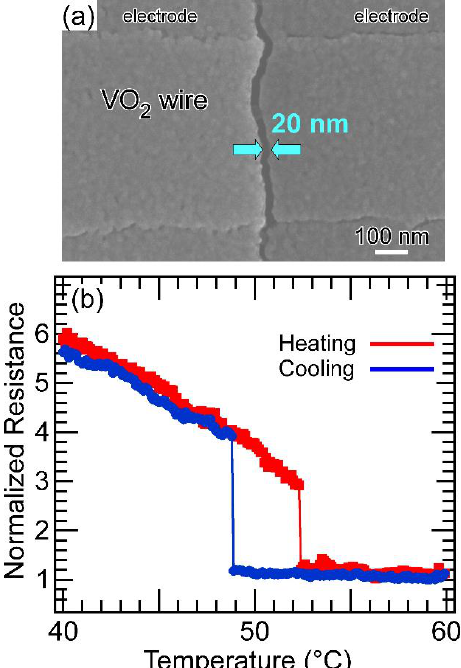
Figure 4. ( a ) Typical SEM image of VO 2 wire with width of 600 nm after depositing a pair of Au/Ti electrodes. The gap distance of the electrodes was 20 nm, which corresponds to the VO 2 region for the electronic resistivity measurement. ( b ) Normalized R - T curve for the VO 2 wire with 20 nm-gap electrodes. One-step changes in resistivity were observed in both the heating (red) and cooling (blue) processes. The resistivity was normalized by the value at 60 °C. The temperature-sweep-rate was 3.0 °C/min.